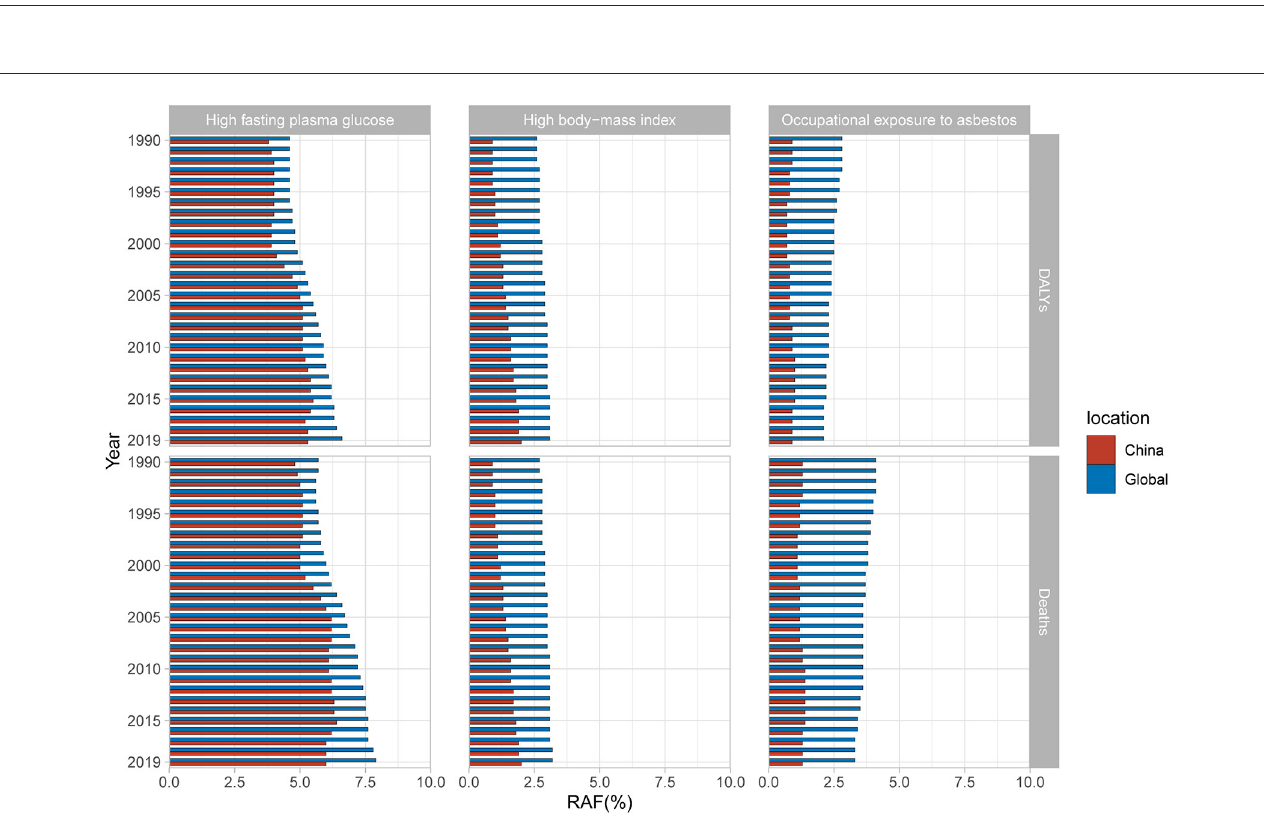
FIGURE6 Population attributable proportion (PAF, %) of associated risk factors for ovarian cancer mortality and disability-adjusted life-years (DALYs) from 1990 to 2019.